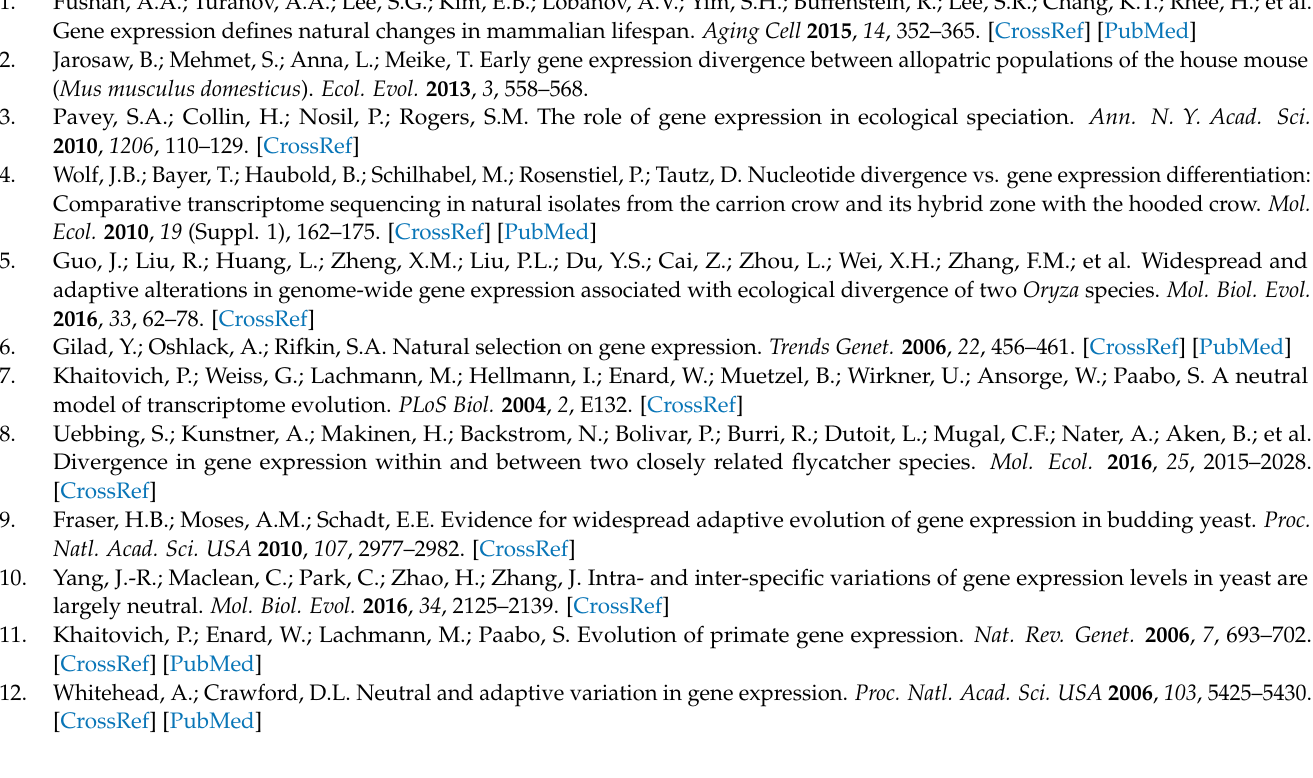
Table S8: Significant enriched Gene Ontology (GO) terms using differentially expressed genes (DEGs) with adaptive expression variation related to resting frequency (RF) in the inter-specific and inter- subspecific comparisons for cochlea. Table S9: Significant enriched Gene Ontology (GO) terms using differentially expressed genes (DEGs) with adaptive expression variation related to forearm length (FA) in the inter-specific and inter-subspecific comparisons for cochlea. File S1: Methods for screening the differentially expressed genes (DEGs) whose expression variation were related to the divergence of forearm length (FA). File S2: Code for the calculation of zFPKM, normalized FPKM values, in R (version